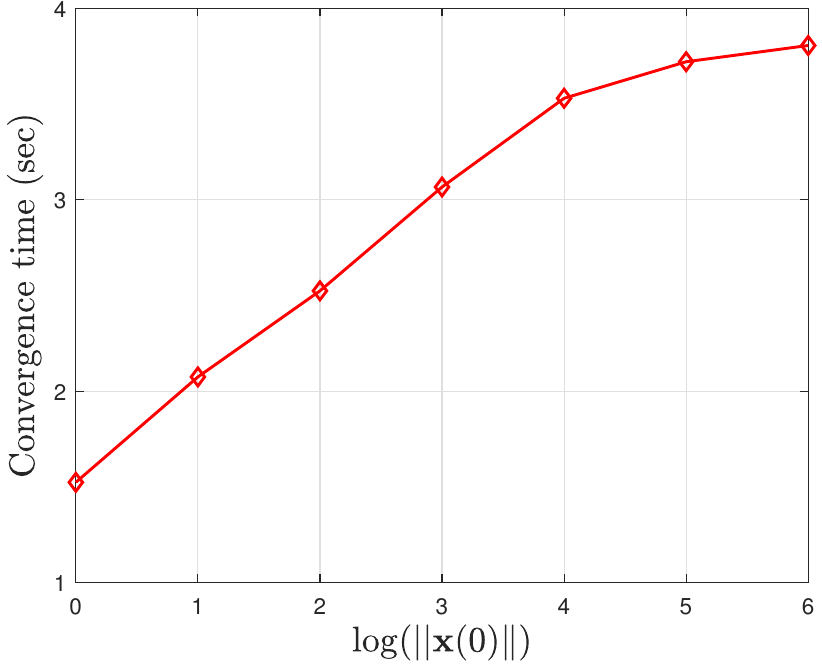
Figure 3. Convergence times for different initial